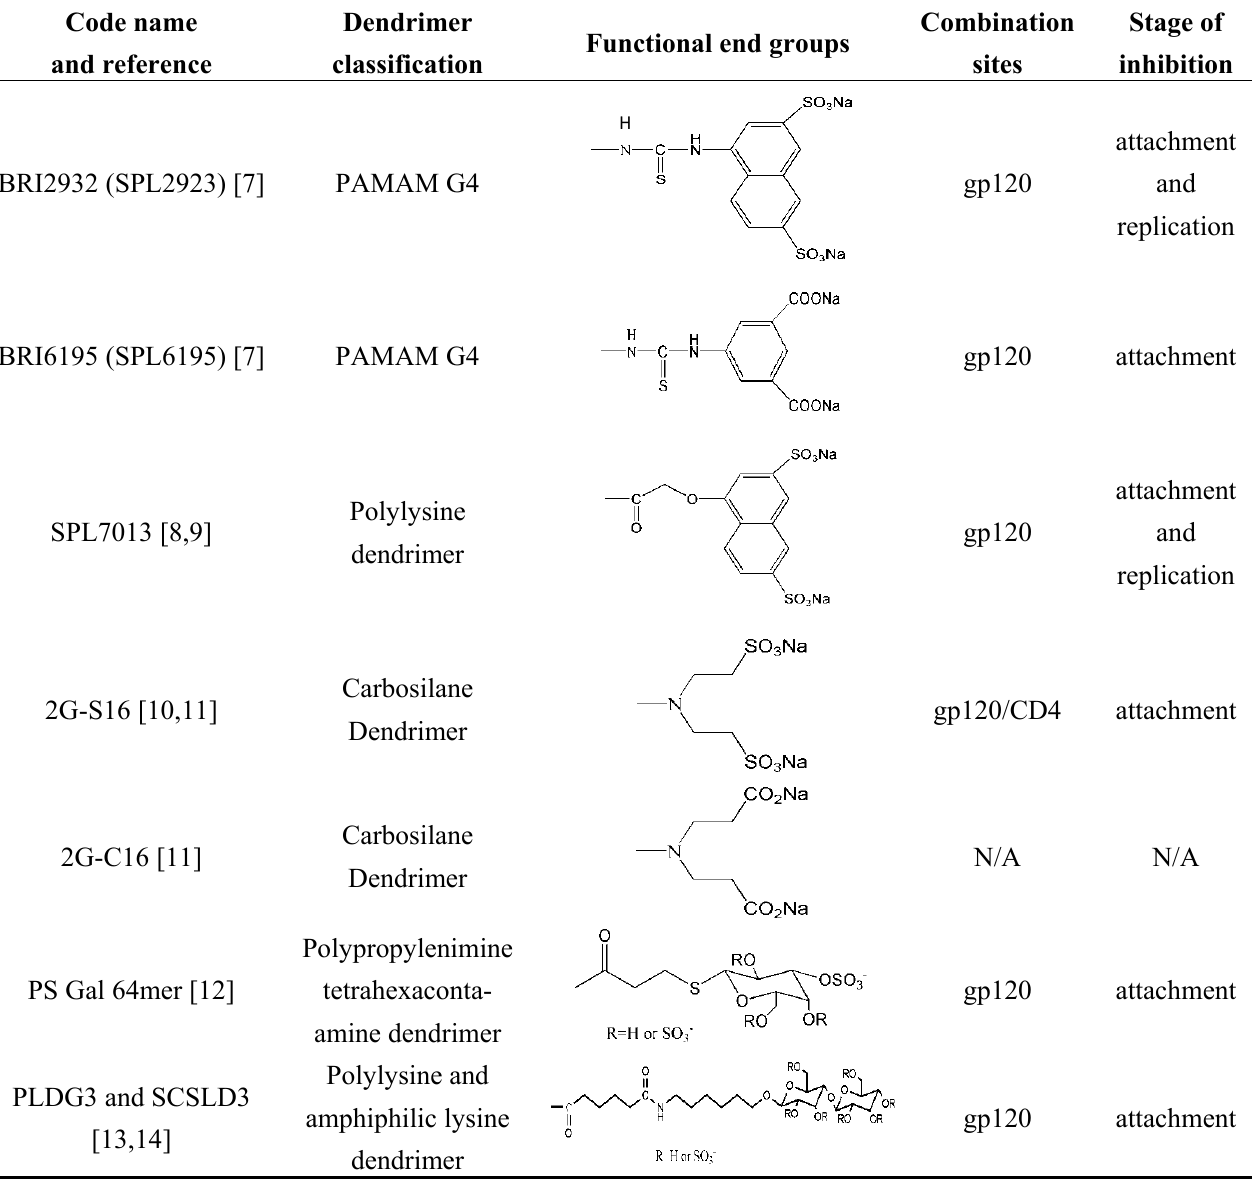
Table 1. The dendrimers with various functional groups for HIV